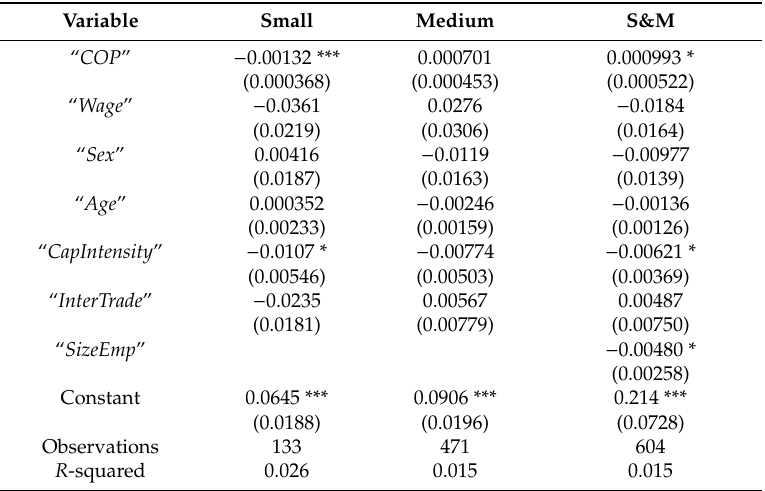
Table 9. Correlates of ROA for small and medium firms.